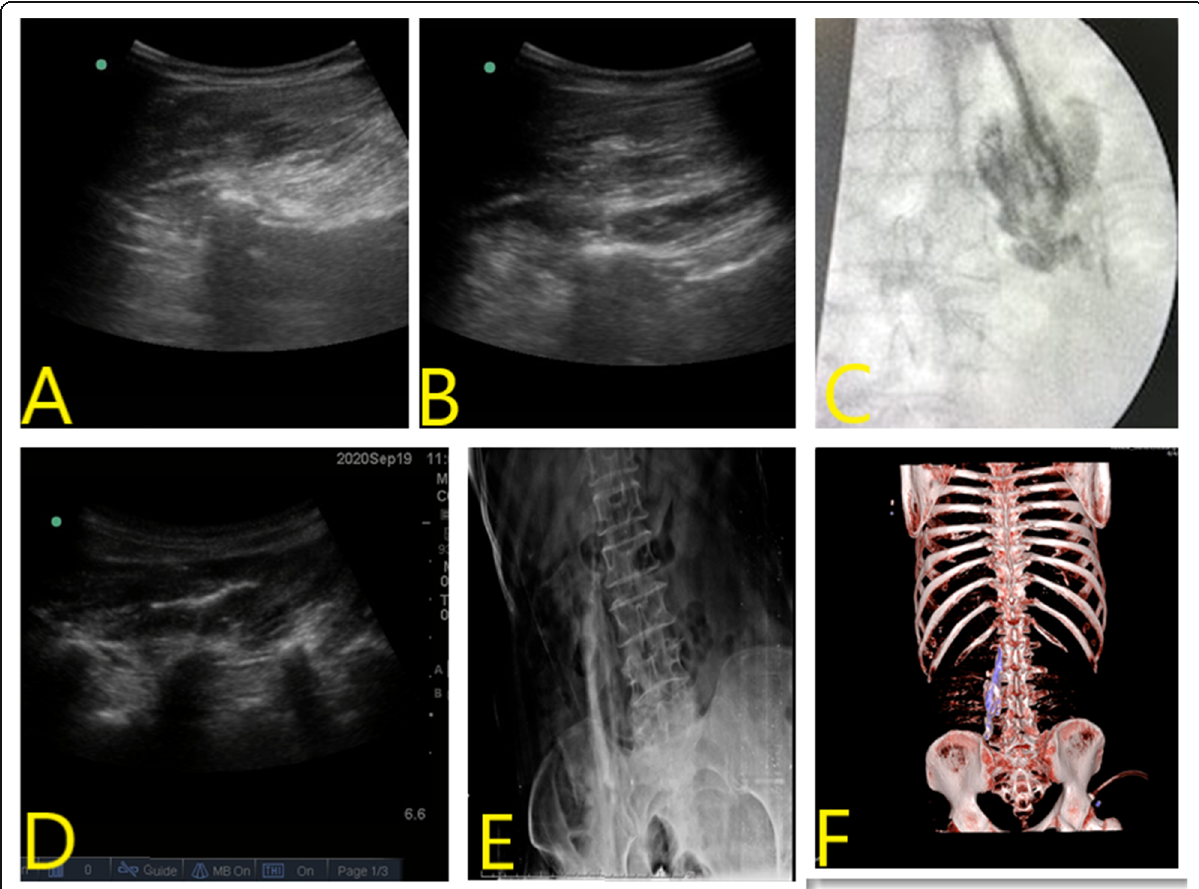
Fig. 1 A Sonoanatomy of the first case, showing the transverse process of L4 vertebra. B Local anesthetic spread (star marks). C X-ray of the first case showing the contrast spread towards lumbar plexus. D Local anaesthetic spread in case 2. E Contrast spread towards lumbar plexus in case 2. F CT of case 3 spread of contrast close to paravertebral spaces. TP — transverse process, ESM — erector spinae